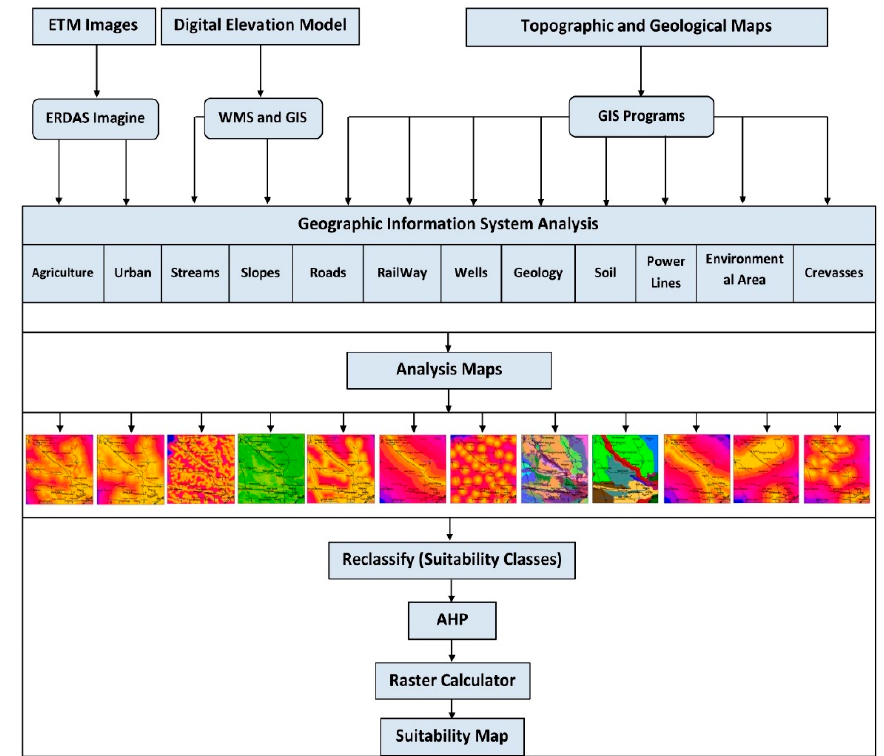
Figure 5. Evaluation of land use suitability for sustainable urban development in the rural–urban continuum (Ar Riyadh–Al Kharj) using the Multi Criteria Decision Analysis (MCDA) technique.